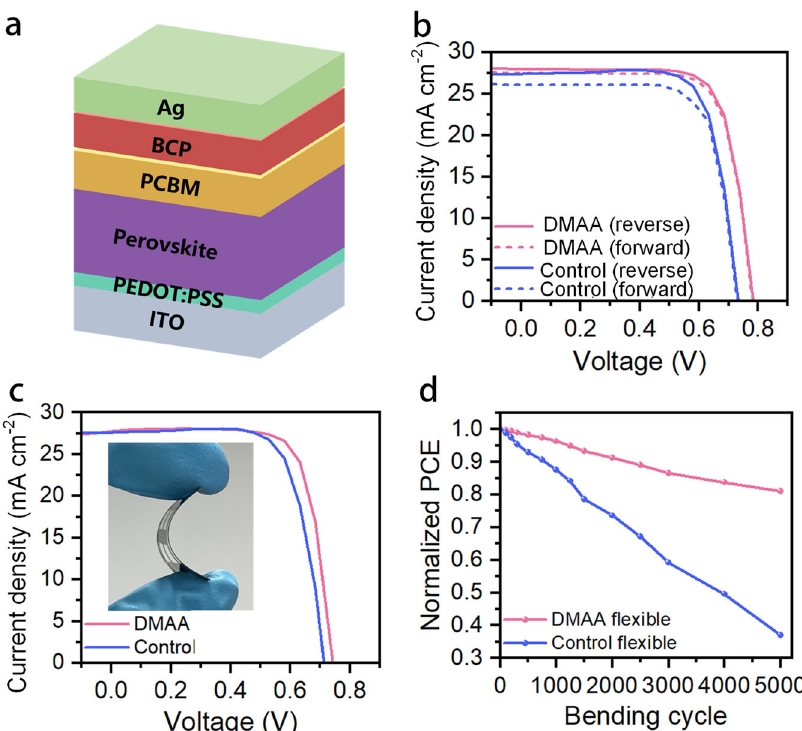
Fig. 3 Photovoltaic performance of Sn – Pb mixed PSCs. a Device structure of the Sn – Pb mixed PSCs. J – V curves of the Sn – Pb mixed PSCs on ( b ) rigid and ( c ) fl exible substrates, the inset of ( c ) shows the picture of a fl exible PSC. d Bending tests of fl exible PSCs with a bending radius of 5